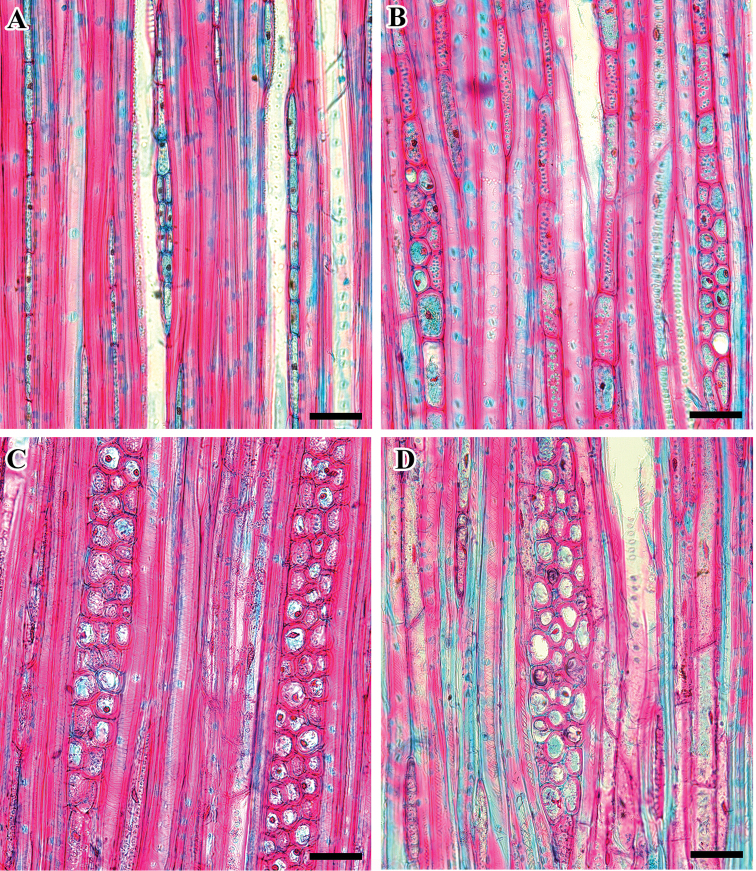
Tangential longitudinal section (TLS) of Viburnum wood showing different types of cells in the ray. AV.
burejaeticumBV.
carlesiiCV.
dilatatumDV.
erosum. Scale bars: 20 µm.